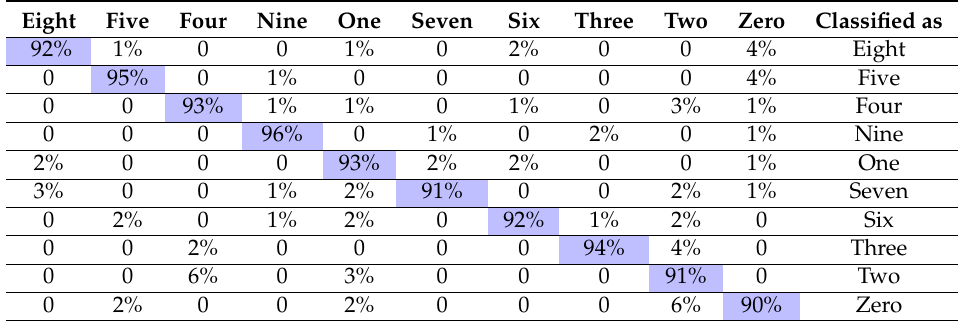
Confusion matrix of n -fold cross-validation (10-fold) results for Urdu handwritten numeral classification.